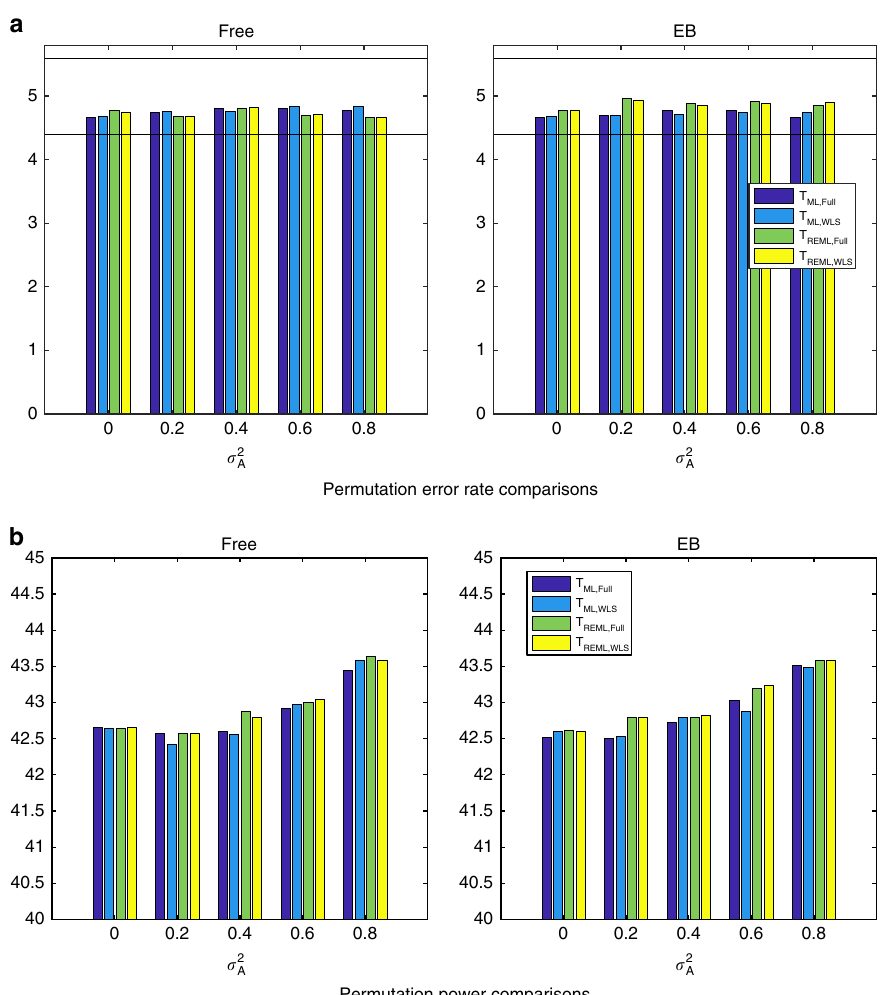
Fig. 1 Comparison of rejection rates for the proposed fi xed effects permutation inference, two different permutation schemes (Simulation 2). Results shown for the null β 1 = 0 ( a ) and alternative ( b ) for a 5% nominal level based on simulation using a GRM from 300 unrelated individuals and 5000 realizations and 500 permutations each realizations; left column shows results for the free permutation scheme, right for the exchangeability-block constrained method. Monte Carlo con fi dence interval is (4.40, 5.60%). For non-iterative and fully converged, both permutation schemes could control the error rate at the nominal level, however free permutation is slightly more powerful than the constrained